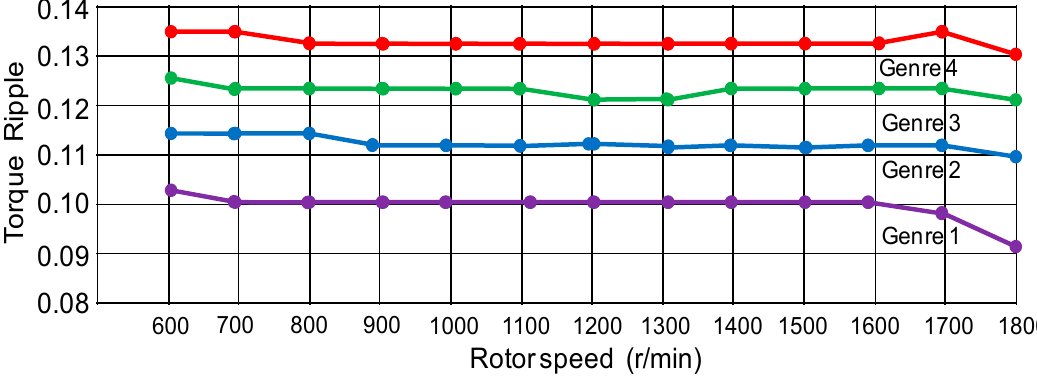
Figure 9. Line chart of performances comparisons for 4 kinds of six-phase synchronous reluctance motors mounted to centrifugal compressor. 3.2. Experimental Results Full cross-section views in four kinds of configuration of six-phase synchronous reluctance motor as genre 1, genre 2, genre 3 and genre 4 is shown in Figure 10 according to present in Table 6. The chosen 4 kinds of six-phase synchronous reluctance motor through optimization design with multi-objective functions have some better performances. Magnetic flux with FEM analysis solutions after two-step optimization design in genre 1 of six-phase synchronous reluctance motor is shown in Figure 11, where Figure 11a is the full cross-section view of three-dimensional diagram at stator and windings, and Figure 11b is the full cross section and quarter cross section of two-dimensional diagram at stator and rotor. It is obvious that the genre 1 of six-phase synchronous reluctance motor has less magnetic saturation effect via optimization design with multi-objective functions. Finally, the completed photo picture of six-phase synchronous reluctance motor is shown Figure 12. The views of stator, rotor and winding, combination and six-phase synchronous reluctance motor mounted to a centrifugal compressor are shown in Figure 12a–c, respectively.